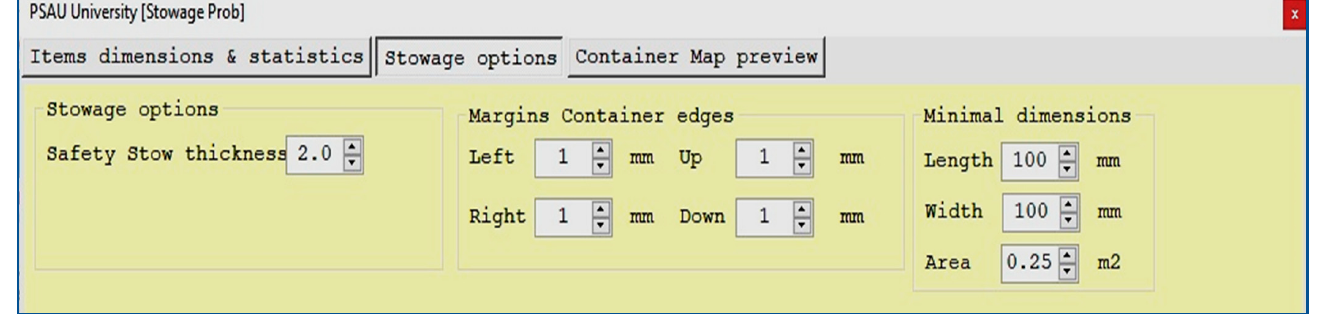
Figure A3. Safety distance of the return products when stowage [0: < Y].